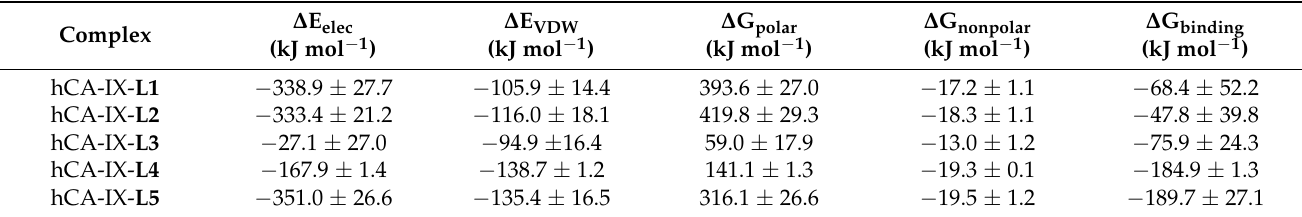
Table 7. Important thermodynamic parameters generated by the MM/PBSA